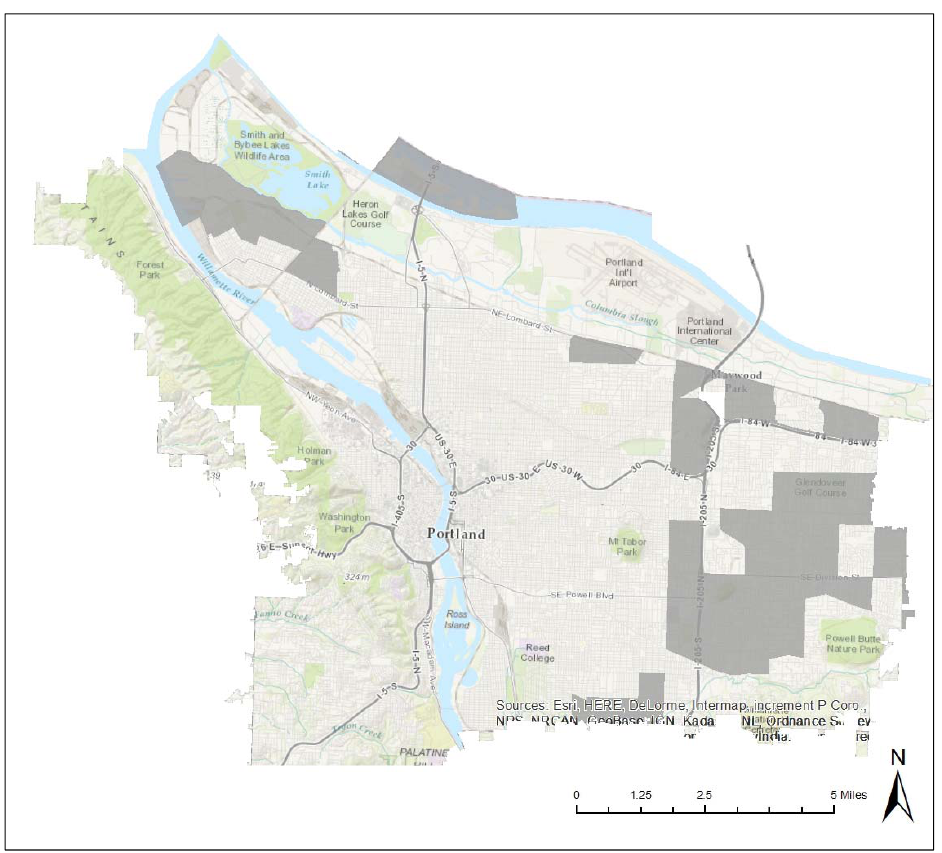
Figure 6. Areas of Need Based on Indicators of Displacement